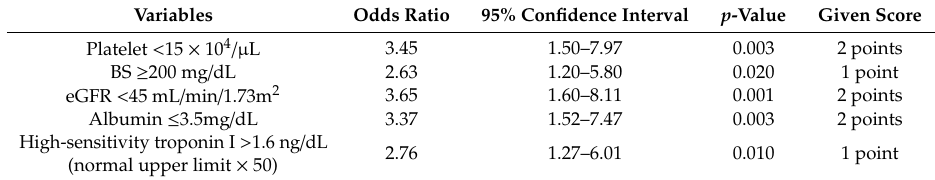
Table 3. Multivariate logistic regression in derivation cohort and corresponding risk score for in-hospital